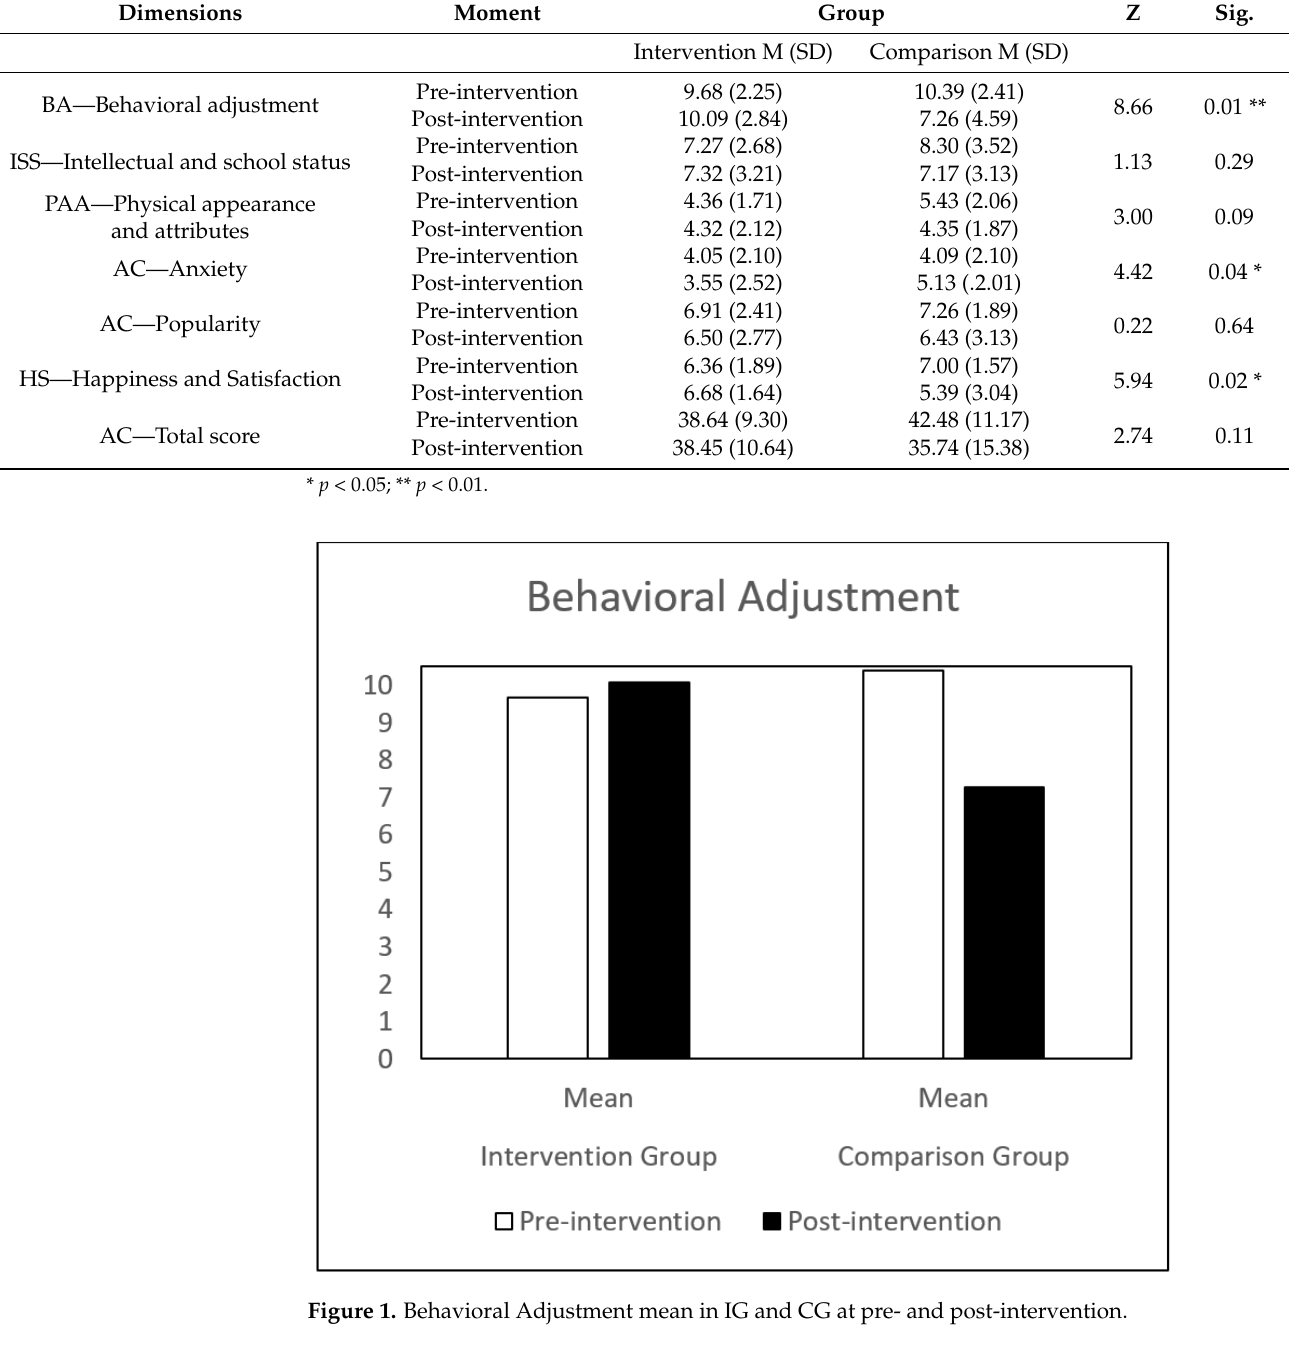
Figure 2. Intellectual and School Status mean in IG and CG at pre- and post-intervention.